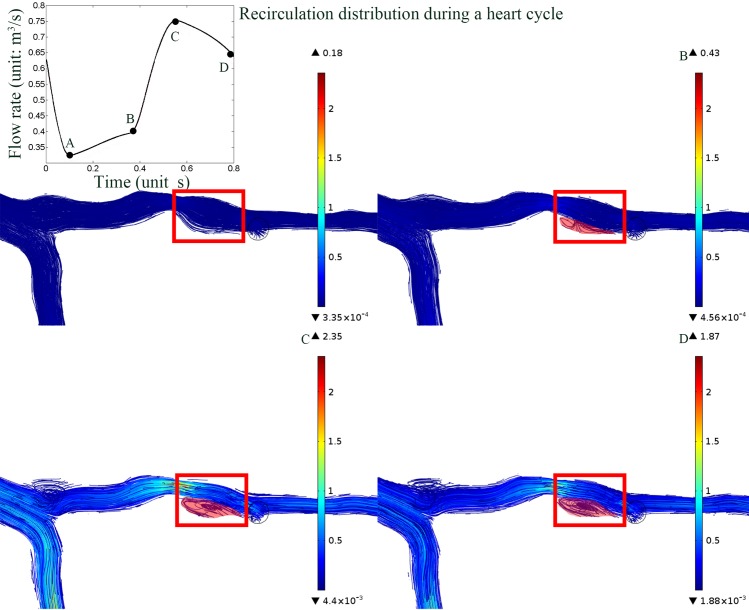
The streamline of the flow distribution color-coded with velocity magnitude.The pulsatile effect of the blood flow on the distribution of the recirculation. A, B, C and D illustrated 4 time points during one cardiac cycle. A: The recirculation disappeared at the low flow rate; B, C and D: The area of the recirculation zone varied along with the flow rate while the lengths of the recirculation zone were relatively consistence (5mm).